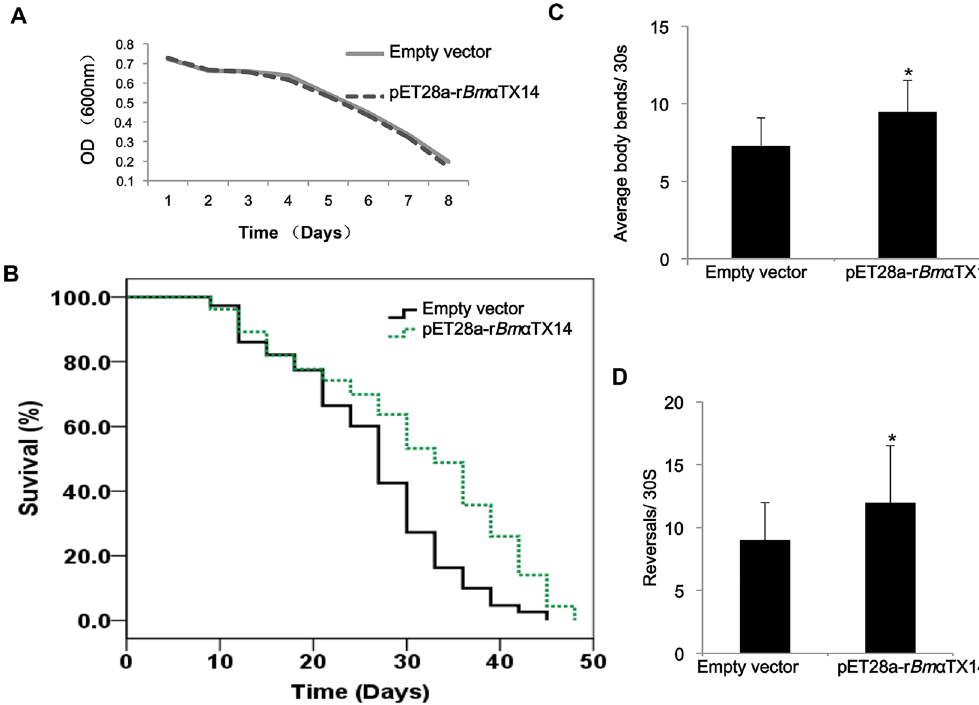
Fig 2. r Bm α TX14 extended the life span and promoted the locomotion of C . elegans . (A) Food clearance assay demonstrating the effects of pET28a-r Bm α TX14 on nematode growth and reproduction. The absorbance (600 nm) was measured daily for a week. (B) pET28a-r Bm α TX14 increased the C . elegans life span. The nematodes were treated with or without pET28a-r Bm α TX14 in 96-well plates. The survival data were plotted using the Kaplan-Meier method and analyzed by log-rank tests using SPSS 17.0 software. Body bend frequency (C) and reversals (D) were analyzed using a SAMSUNG SCC-101BP device and VideoMach software (Data were expressed as mean values ± SD, * p < 0.05). 100 worms were observed for each condition in motility assays, and the data represent an average of at least three independent